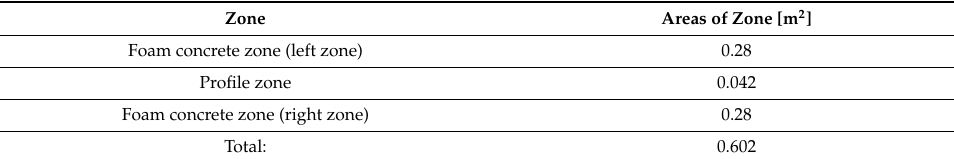
13 of 16 Figure 12. Sample No. 3 with installed thermal and temperature sensors. Based on the data obtained, the most temperature-stabilized estimated time intervals were selected, and graphs of temperature on the specimen No. 3 surface versus time and of heat flow versus time were plotted (see Figures 13 and 14).